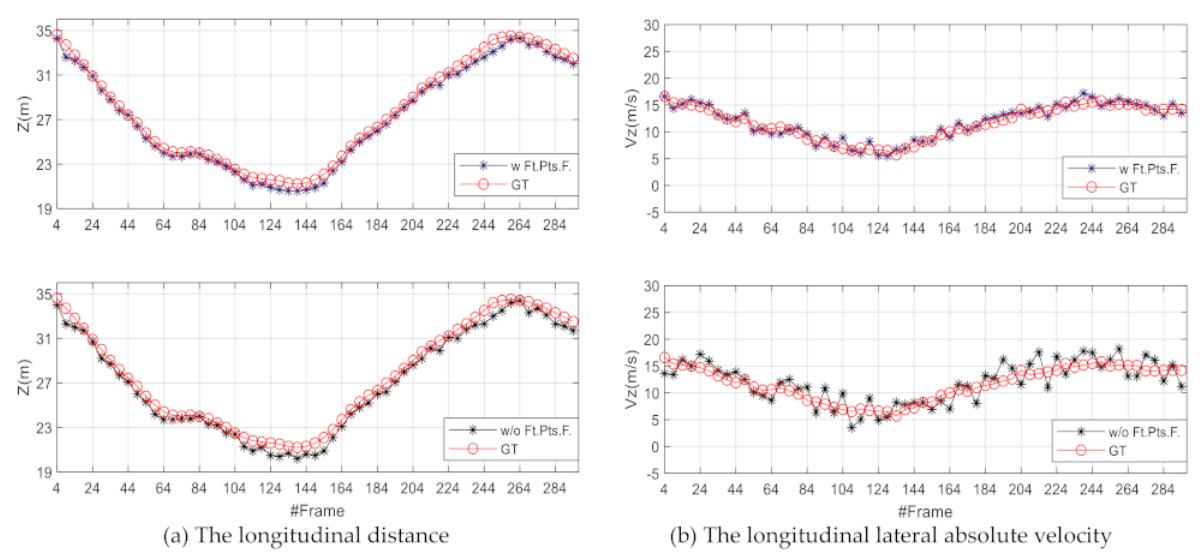
Figure 9. Variations of longitudinal distance and velocity of Obj. 2 over frame 4–294 in Road scene. ( a ) The longitudinal distance; ( b ) The longitudinal lateral absolute velocity.